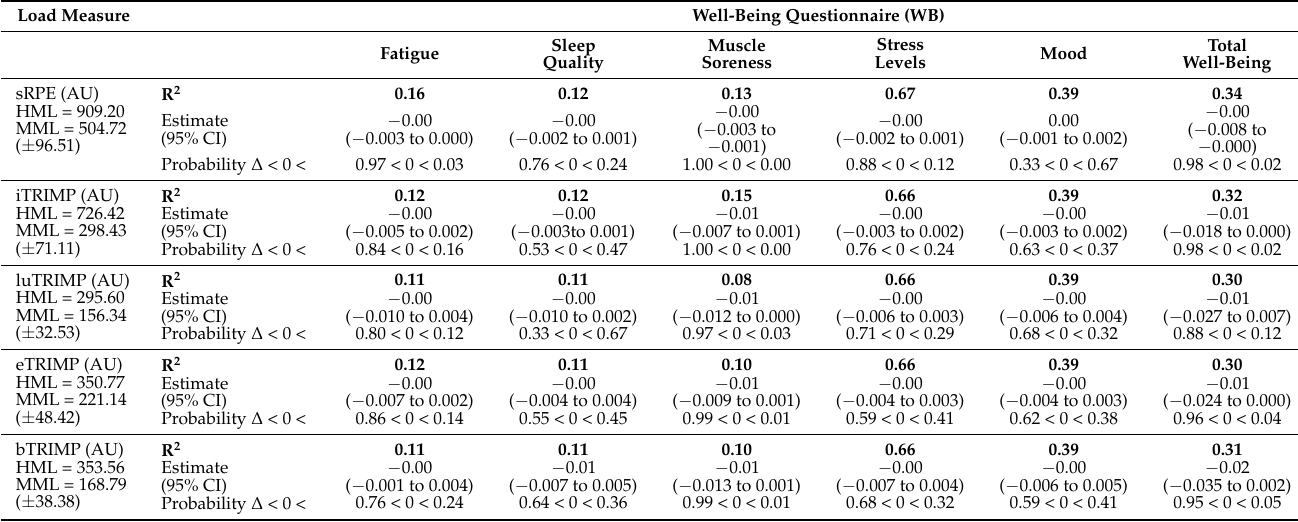
Table 2. Bayesian linear mixed model analysis of the relationship between internal load measures (independent variable) and next-day well-being questionnaire (WB) ( n = 10).